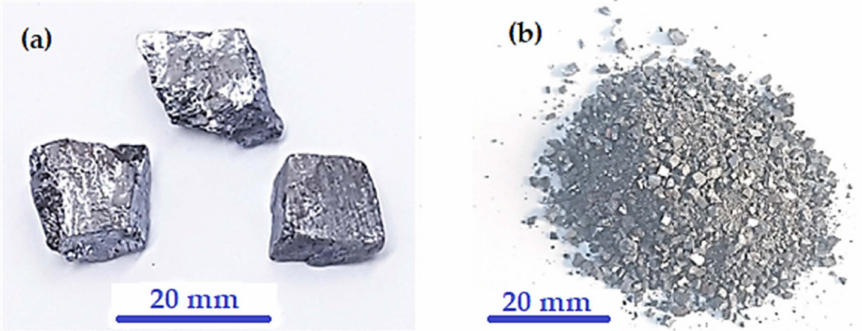
Figure 5. ( a ) The as-received starting galena lumps. ( b ) Rough pulverized galena